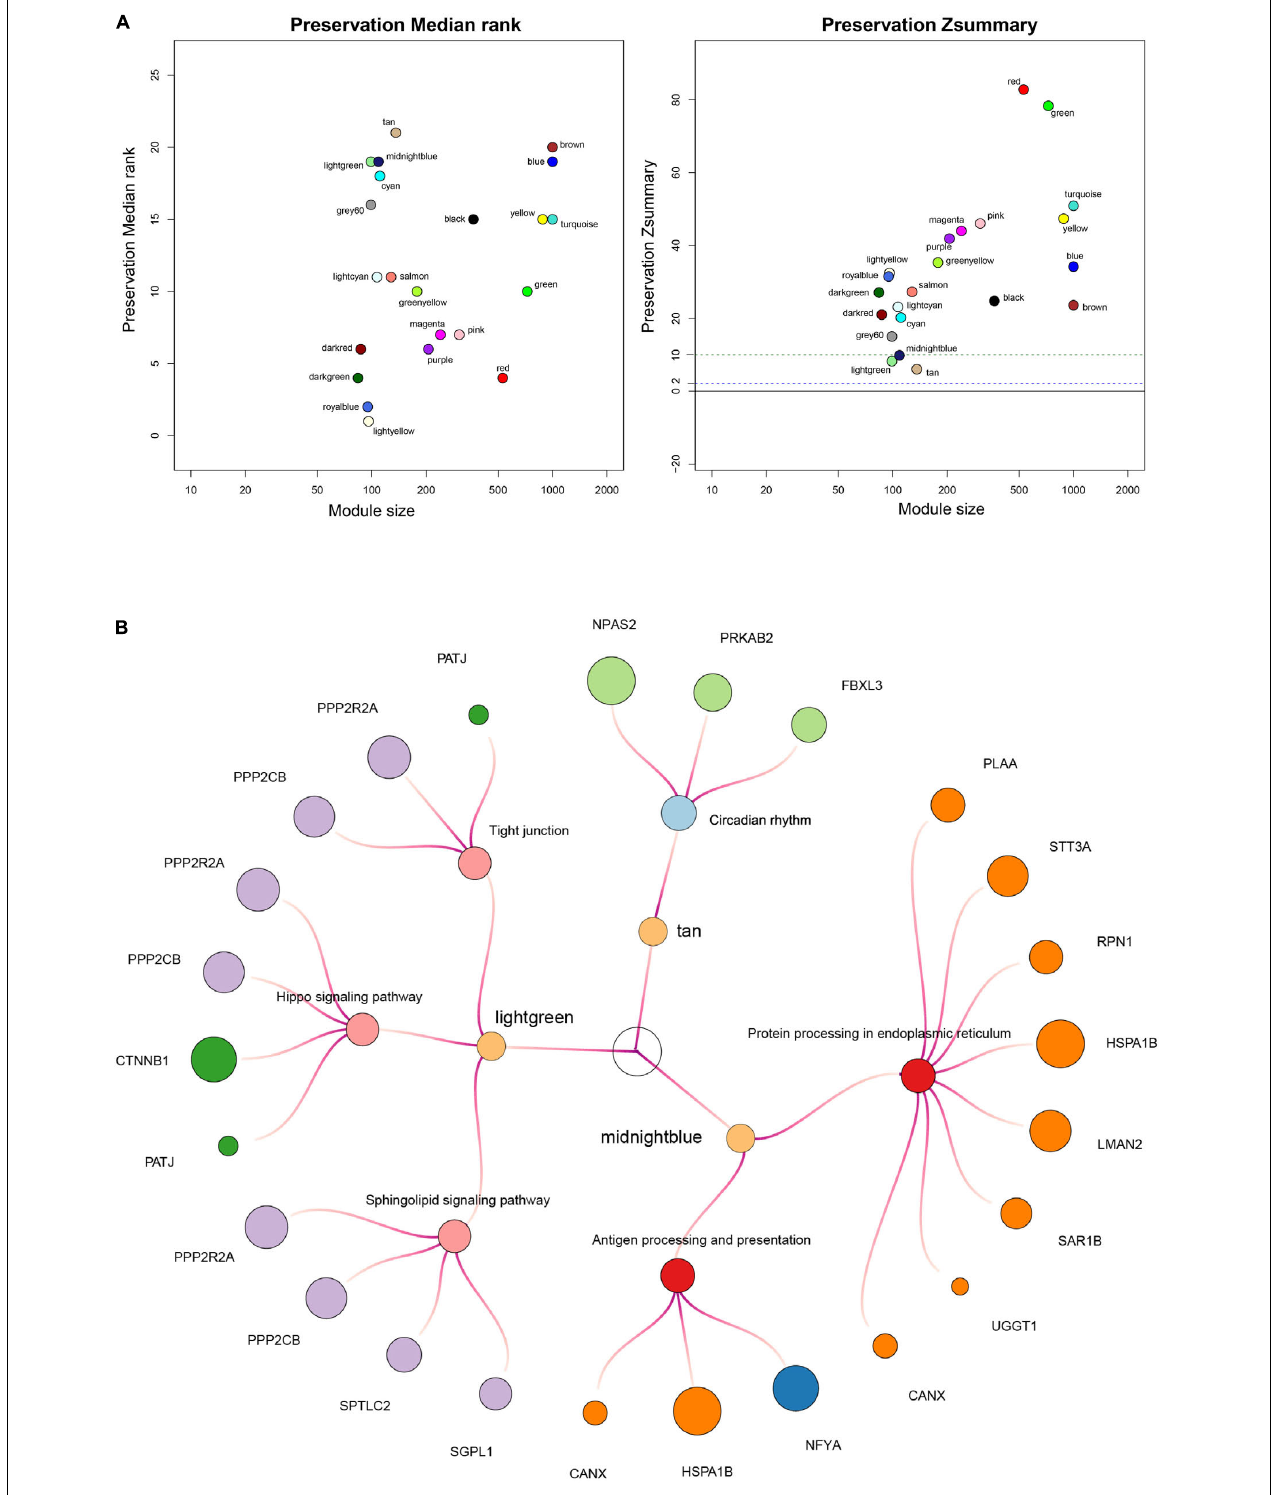
FIGURE 8 | Construction of weighted co–expression network and identification of key modules. (A) Each module is represented by its color-code and name. Left plot shows the preservation median rank, which tends to be independent from module size with high median ranks indicating low preservation. Right plot shows Z -score value. The green dotted line indicates that Z -score is equal to 10. Z -score < 10 represents weak preservation. (B) Enriched KEGG pathways with p -values < 0.05 were presented. KME value (eigengene connectivity) of module internal hub genes was indicated by dots’ size, respectively.